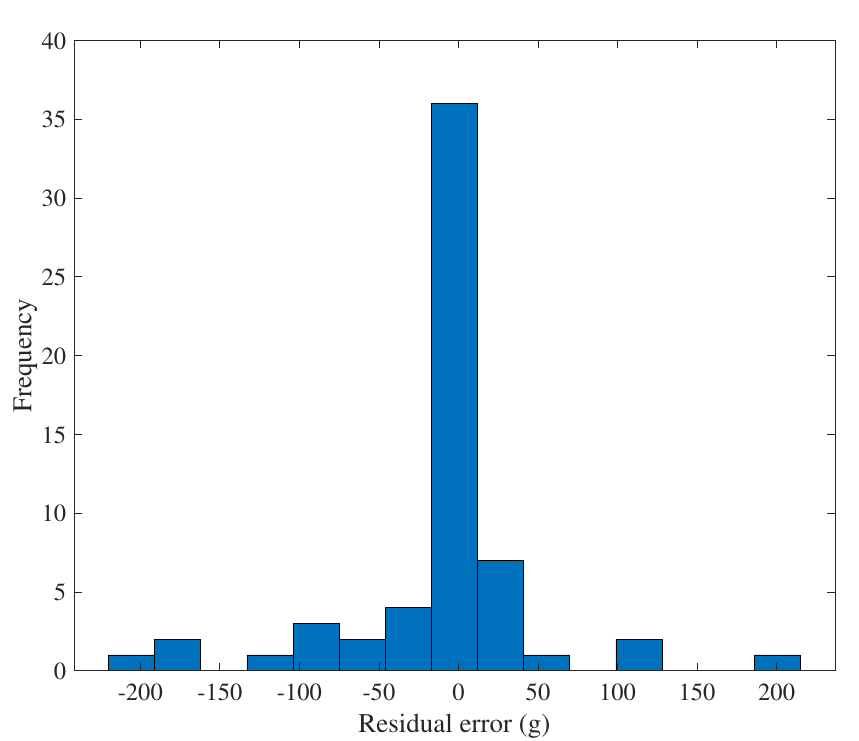
Figure A7. Histogram of overall residual error. The bin size of 11